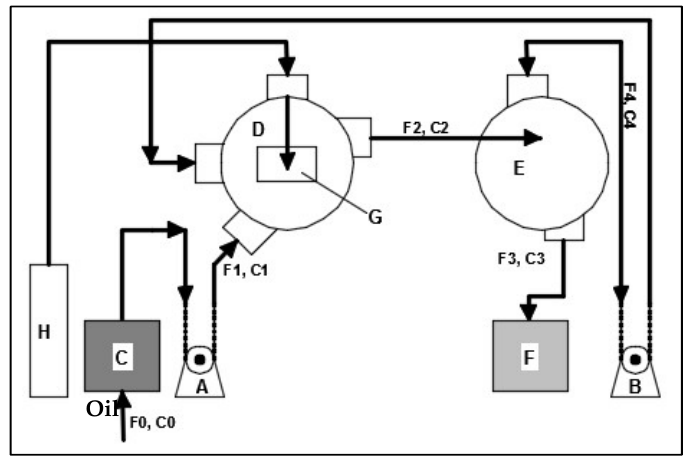
Figure 1. The experimental equipment. A: Feed pump. B: Recirculation pump. C: Feed tank. D: Aeration tank. E: Sedimentation tank. F: Effluent collection tank. G: Block of oxygenation. H: Airflow meter. F0, C0: Flow and concentration of oil entering the feed tank, respectively. F1, C1: Flow and concentration of feed oil to the aeration tank, respectively. F2, C2: Flow and concentration of fats and oils are leaving the aeration tank, respectively. F3, C3: Flow and concentration of fats and oil of the purified effluent, respectively. F4, C4: Flow and concentration of fat and oil in the recirculation flow rate, respectively.